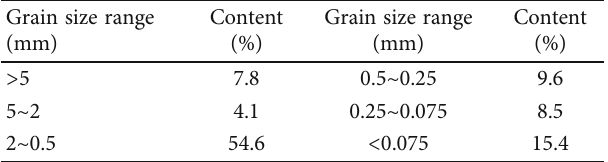
Table 1: Grain size composition of powdered coal-bearing soil. Grain size